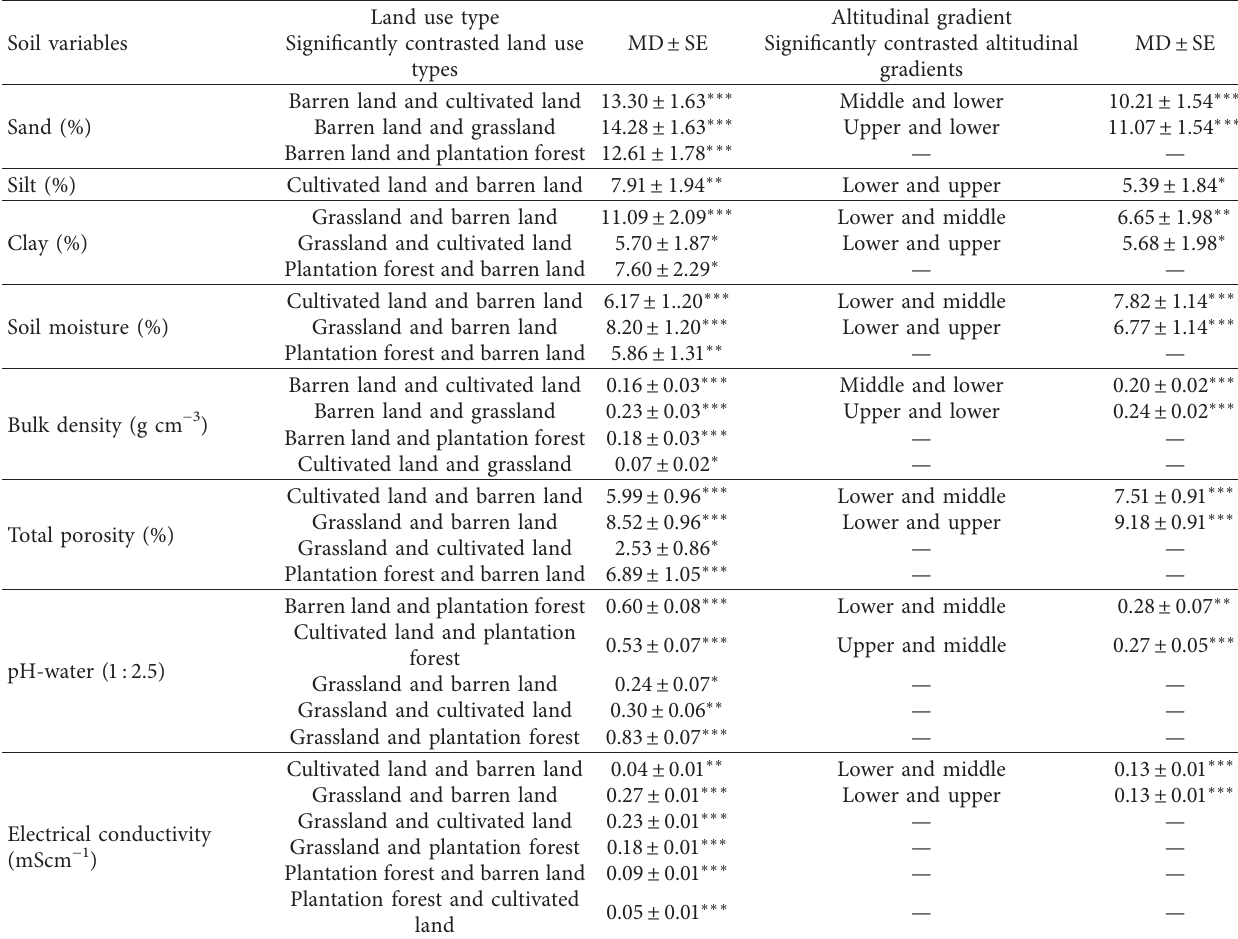
Table 5: Results of post hoc multiple comparison (Bonferroni test; p < 0.05) for soil physicochemical properties with a significant difference by land use type and altitudinal